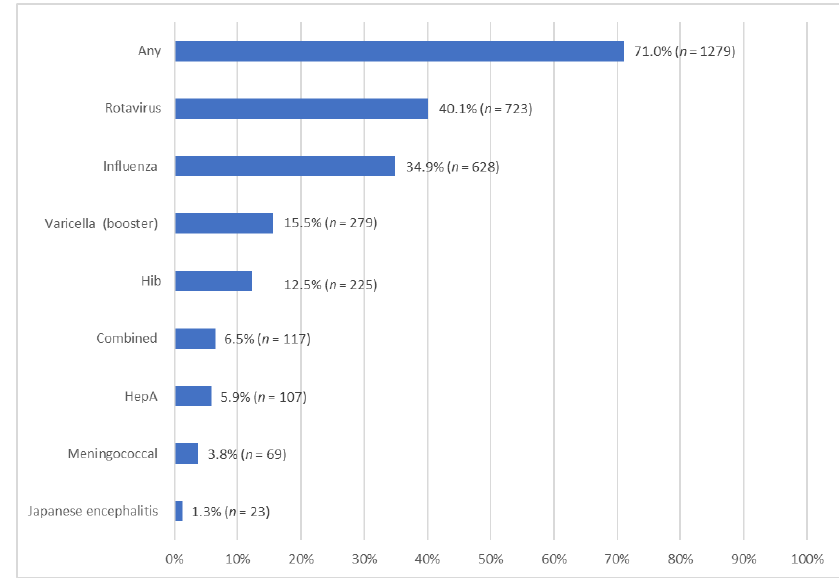
Figure 2. Uptake rate of addition vaccination.